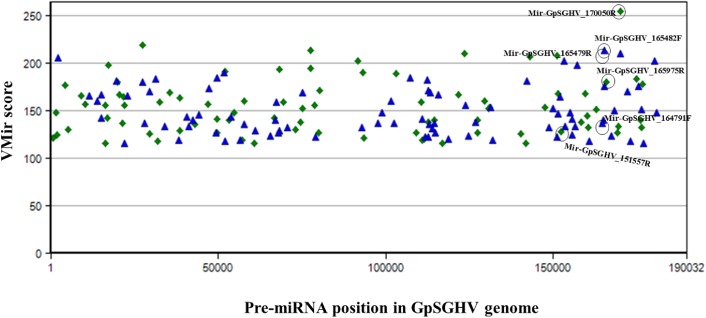
Distribution of predicted pre-miRNA hairpins on the GpSGHV-UGA genome. The hairpins are plotted according to their location on GpSGHV-UGA genome and their VMir score. Only the hairpins with VMir score of above 115 and that can fold in 35 or more windows are plotted. The green diamonds indicate the hairpins on the reverse orientation while the blue triangles indicate the hairpins on the forward orientation. The hairpins corresponding to the miRNAs identified by NGS are circled in black.